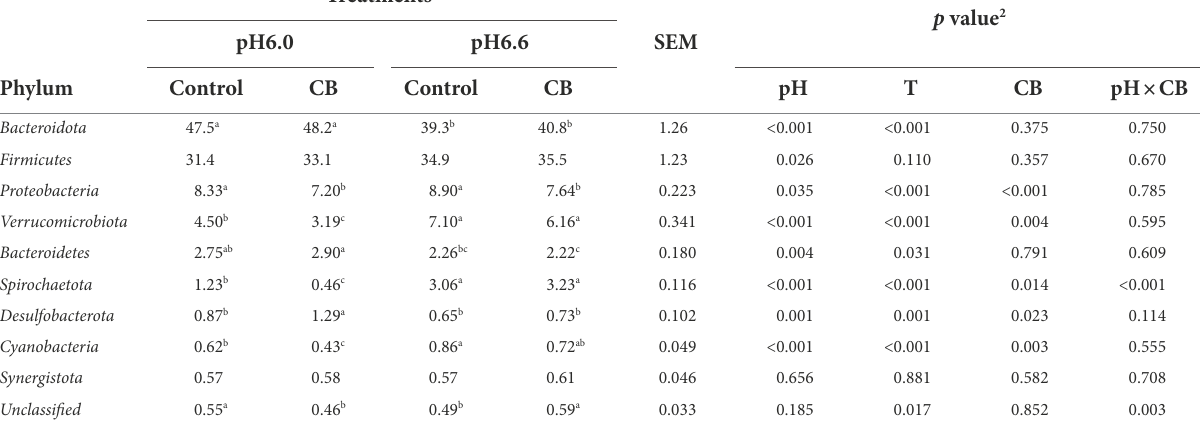
TABLE 4 The relative abundance (%) of bacterial phylum in fermentation fluid supplemented with CB and without CB (Control) at low or high media pH after 24 h of in vitro